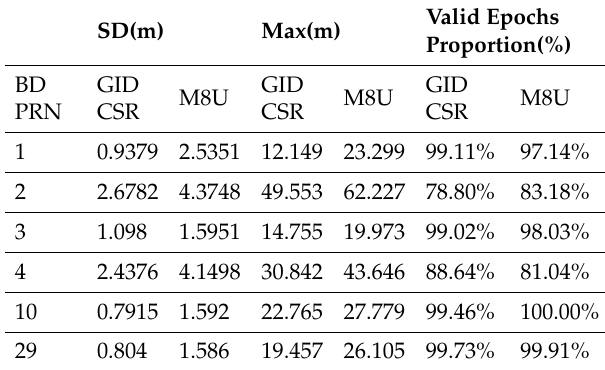
Table 4. BD Satellites pseudo-range measurement performance (GIDCSR v.s u-blox